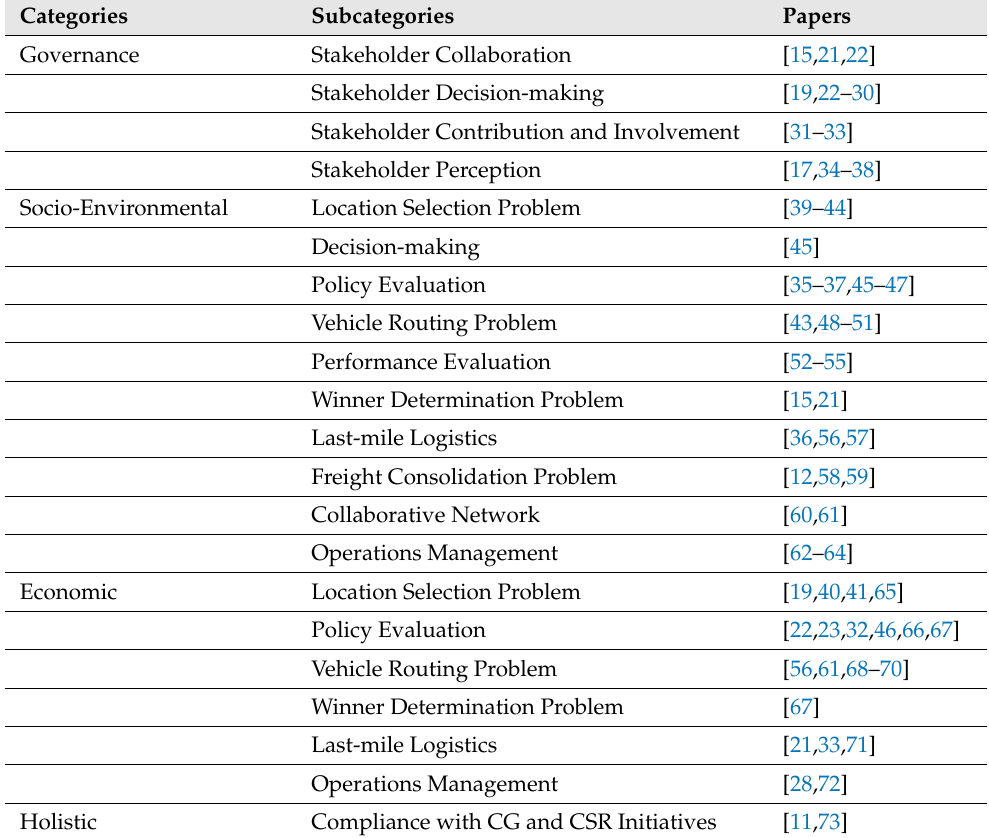
Table 7. Classification of the reviewed